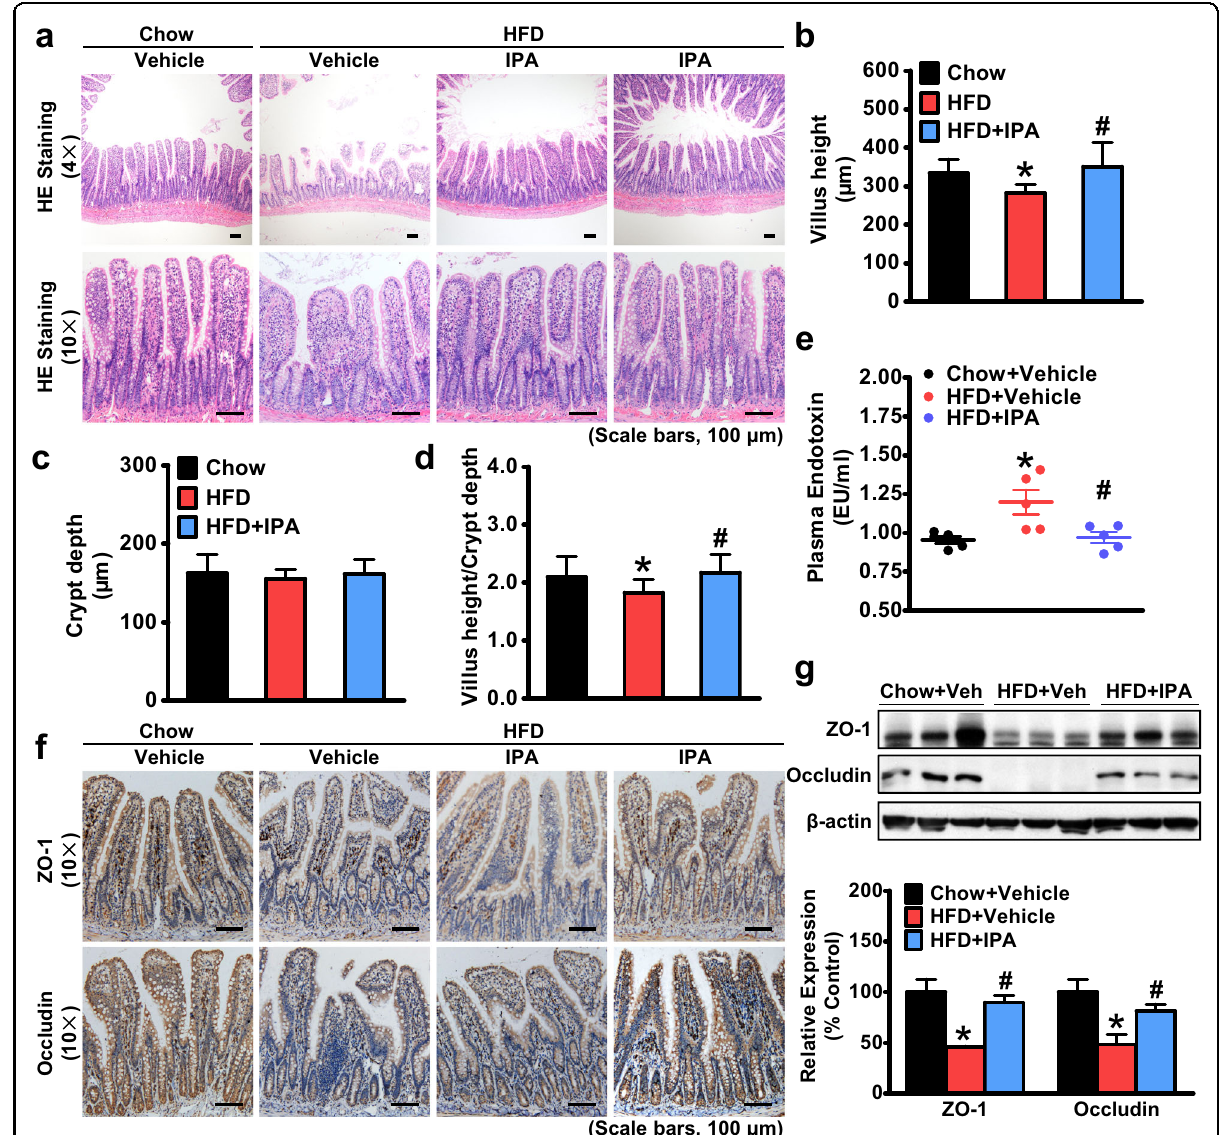
Fig. 2 IPA is able to improve intestinal epithelial barrier damage and consequently inhibit endotoxin secretion in rats fed a high-fat diet. Six-week-old male rats were fed a high-fat diet for 8 weeks and then gavaged with IPA (20 mg/kg/day) once daily for 8 weeks. Rats were sacri fi ced at the end of the 16th week, and ilea were harvested. a Representative hematoxylin and eosin staining of the ilea is shown. The height of the villi ( b ) and the depth of the crypts ( c ) were measured, and the ratio of villus height to crypt depth ( d ) was calculated. e The plasma level of endotoxin was measured using a Limulus amebocyte lysate (LAL) chromogenic assay ( n = 5). f Representative immunostaining of zonula occluden-1 (ZO-1) and occludin in the ilea is shown. g Protein levels of ZO-1 and occludin of intestinal epithelial cells in the ilea. Representative immunoblots and densitometric quanti fi cation from three rats in each group are shown. The data are presented as the mean ± SEM. n = 9 – 10, * P < 0.05, vs. rats fed a chow diet; # P < 0.05, vs. rats fed a high-fat